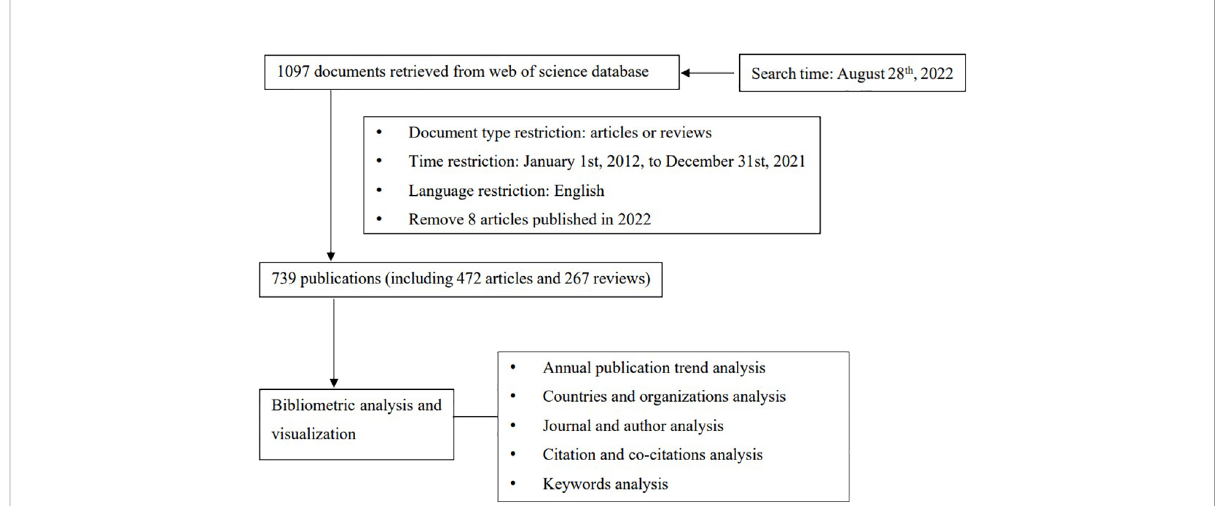
FIGURE 1 The process of literature search and